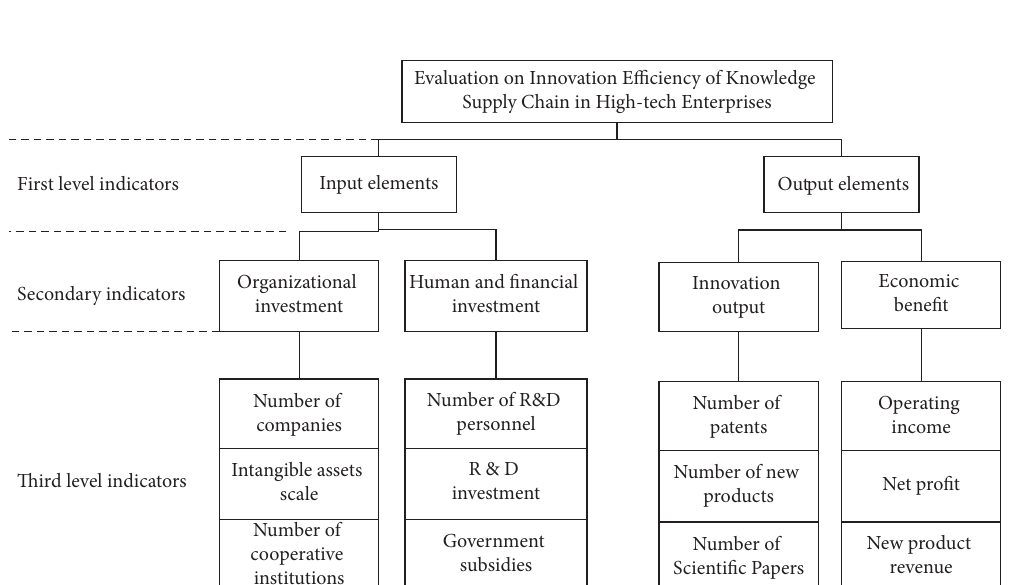
Figure 1: Knowledge supply chain model.